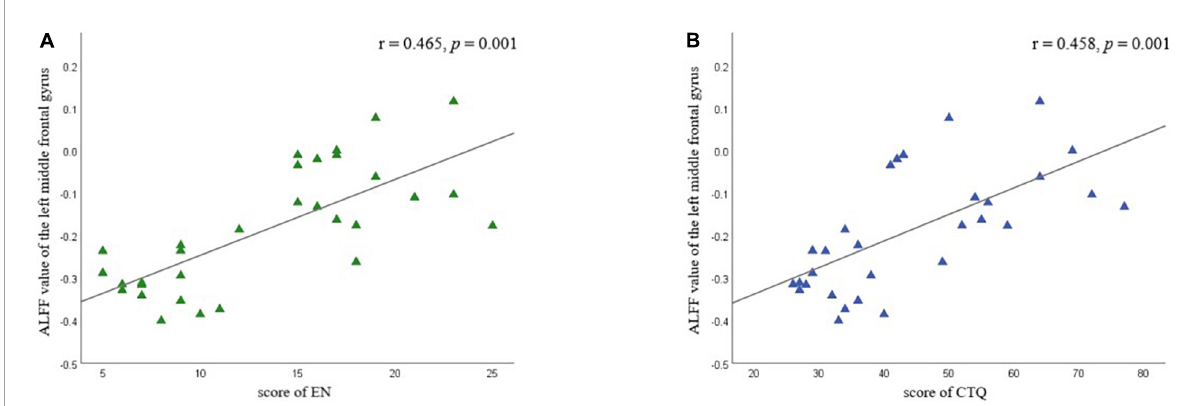
FIGURE5 Partial correlation analyses between amplitude of low-frequency fluctuation value (ALFF) in left middle frontal gyrus and childhood trauma scores in different subscale were performed by combining all of MDD participants as a whole. Age and education were considered as control variables. (A) Shows the correlation between EN scores and ALFF value of the left middle frontal gyrus; (B) shows the correlation between CTQ total scores and ALFF value of the left middle frontal gyrus. EA, emotional neglect.